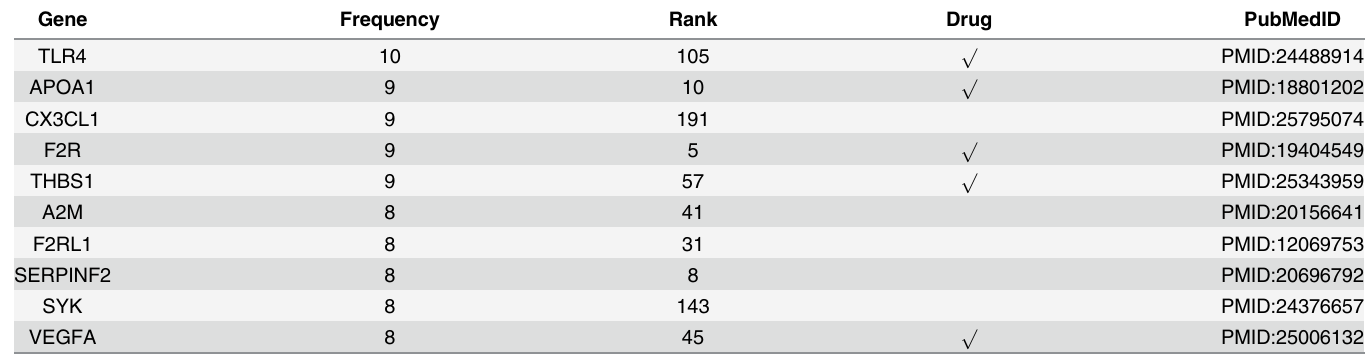
Table 2. The candidate genes in more than eight functional categories.